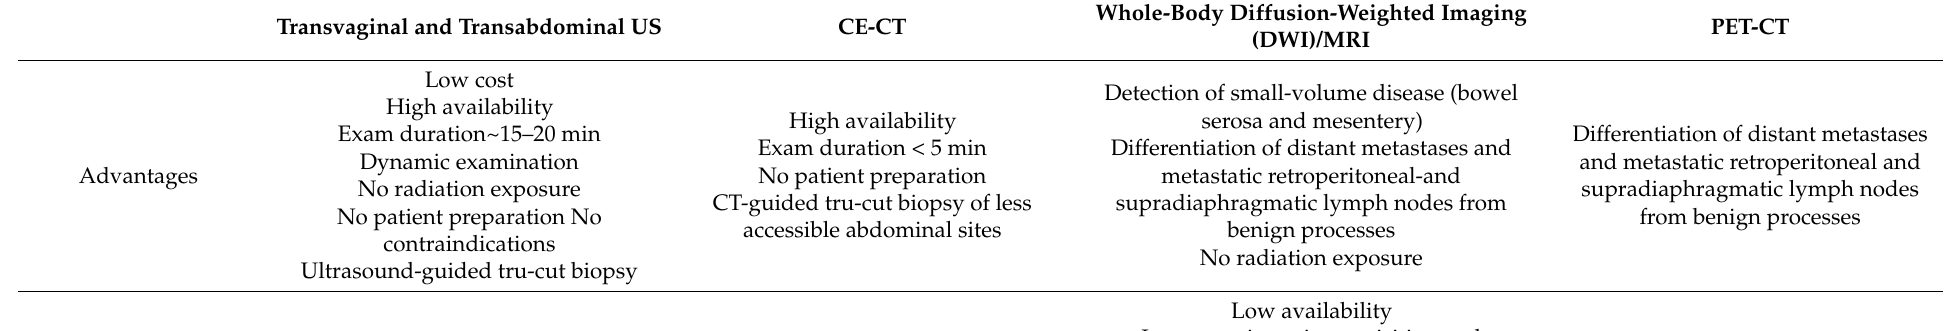
Table 4. Comparison of different diagnostic imaging methods used in ovarian